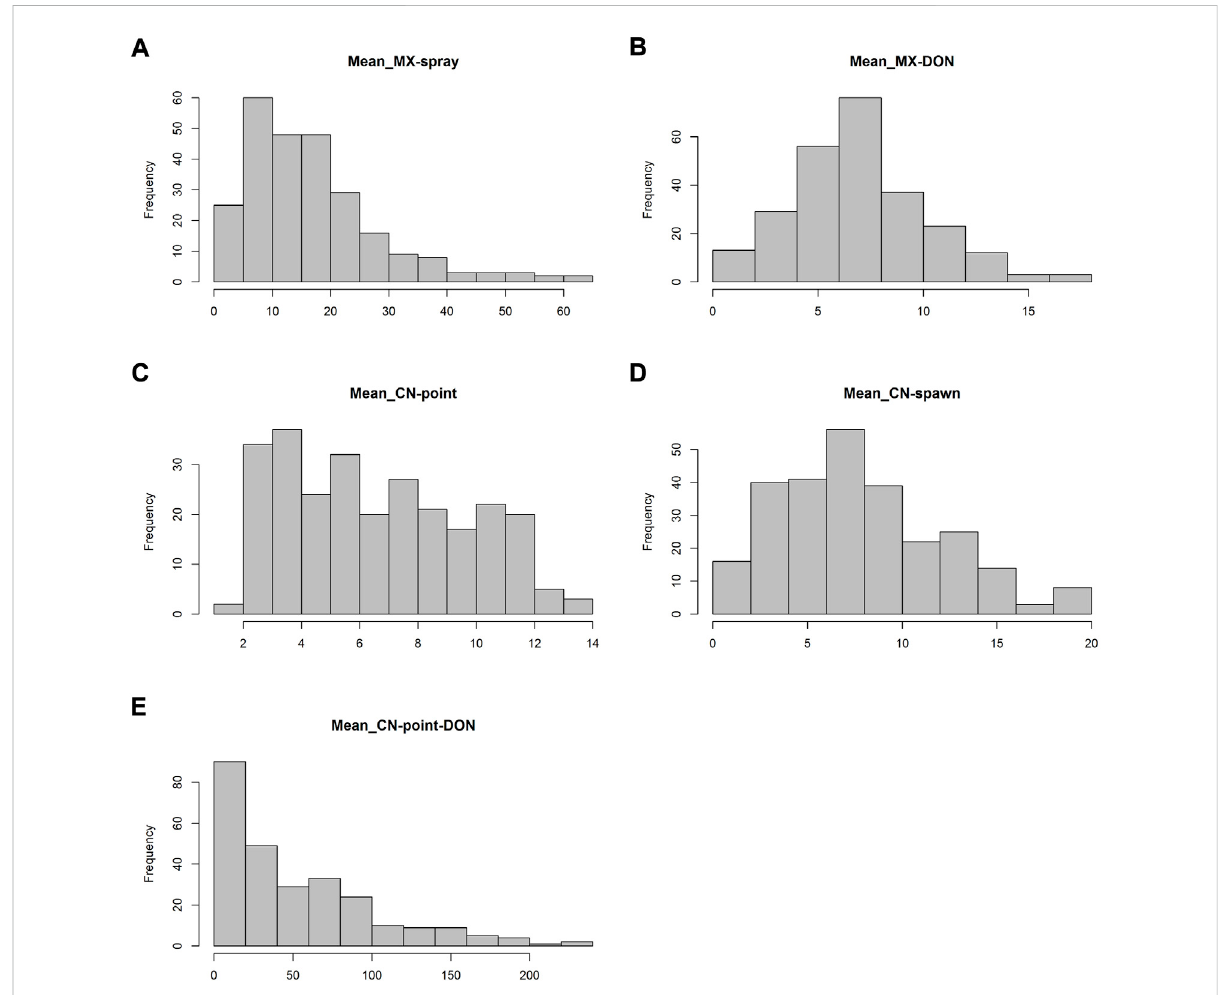
FIGURE 1 Frequency distributionofFHBindex (A) ,numberofdiseased spikelets (Cand D) andDON contentingrains (BandE) basedon themeandata in Mexico (MX, spray inoculation) and China (CN, point and spawn